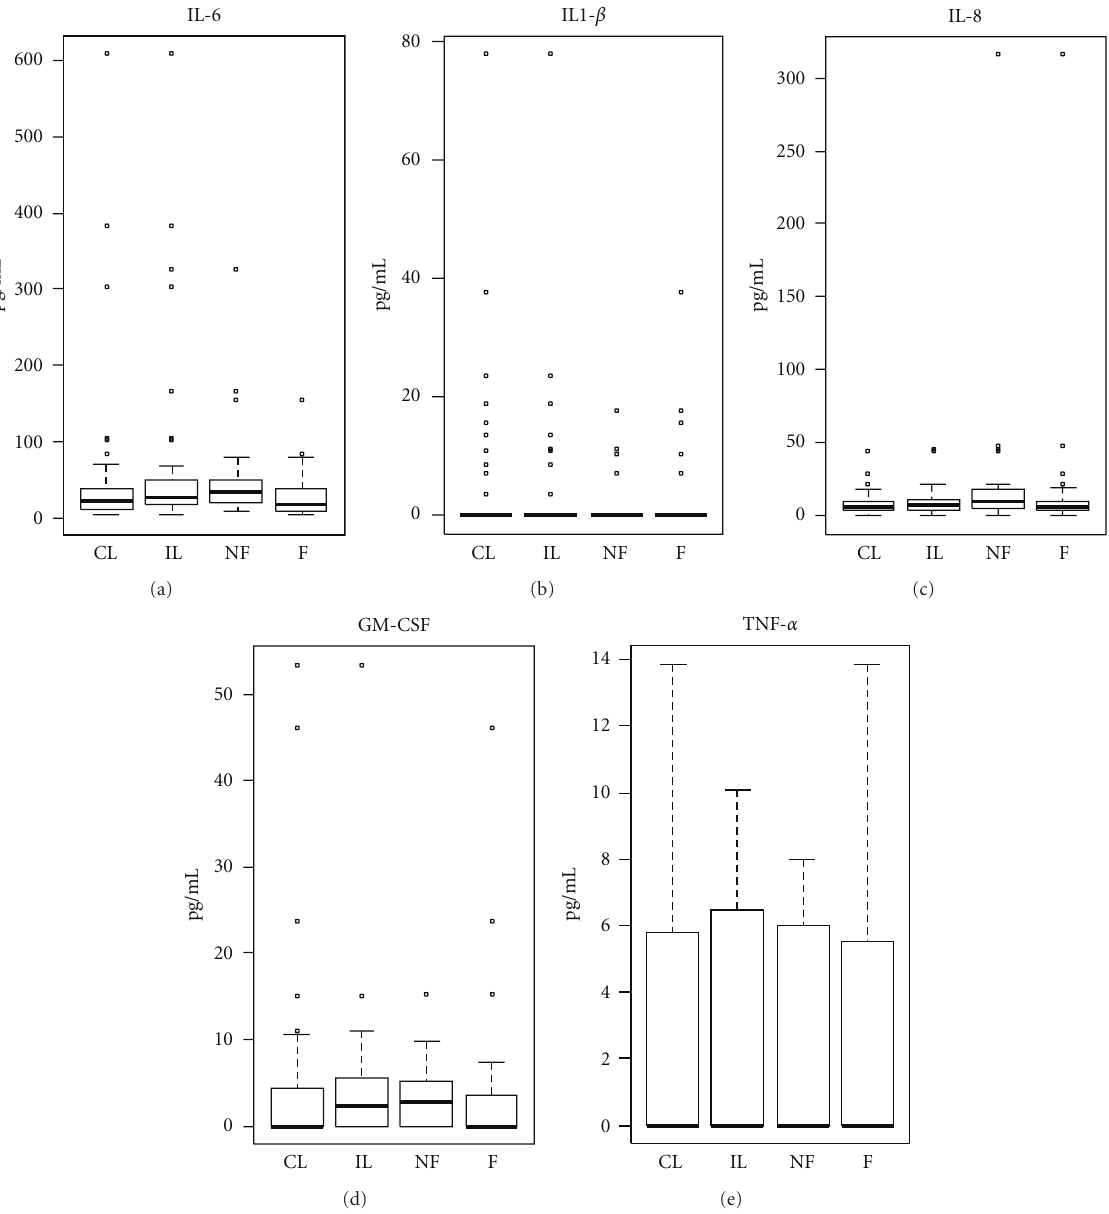
Figure 3: Box plots of cord serum cytokines in the four groups studied. IL-6: interleukin-6, IL-1 β : interleukin-1 β , IL-8: interleukin-8, GM- CSF: granulocyte macrophage-colony stimulating factor, TNF- α : tumor necrosis factor- α . IL:ILEA group. CL: CLEA group. NF: afebrile group. F: febrile group. There were no significant CLEA versus ILEA or F versus NF di ff erences in any